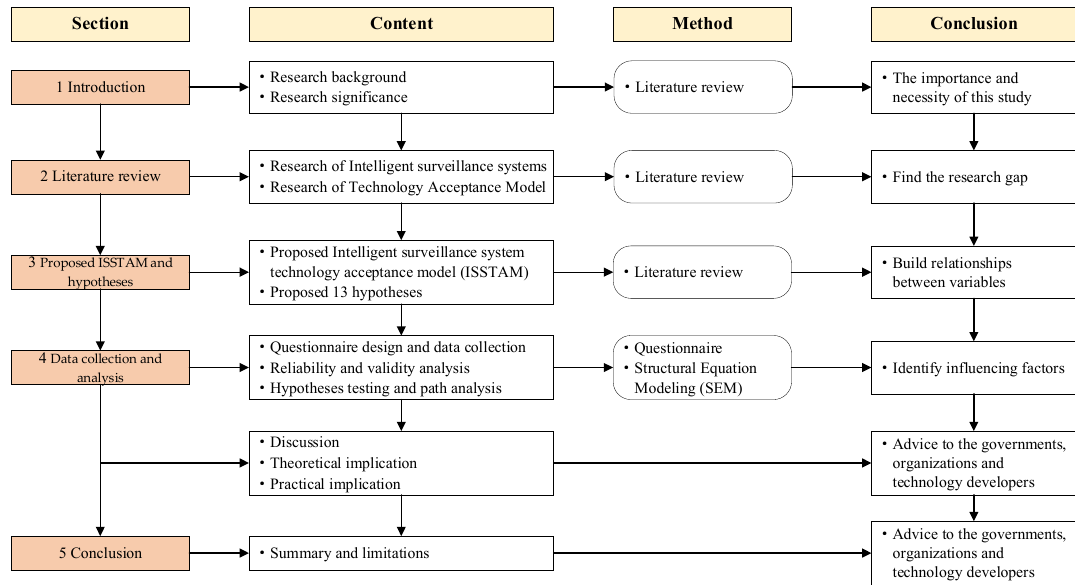
Figure 1. Research framework.